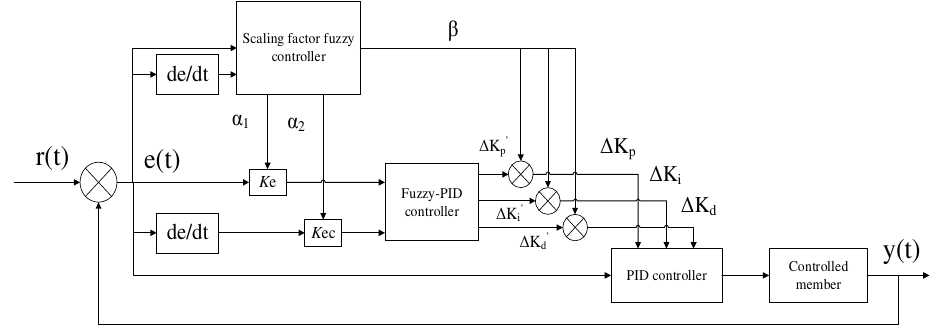
Figure 6. Schematic diagram of fuzzy PID control in variable theory domain.